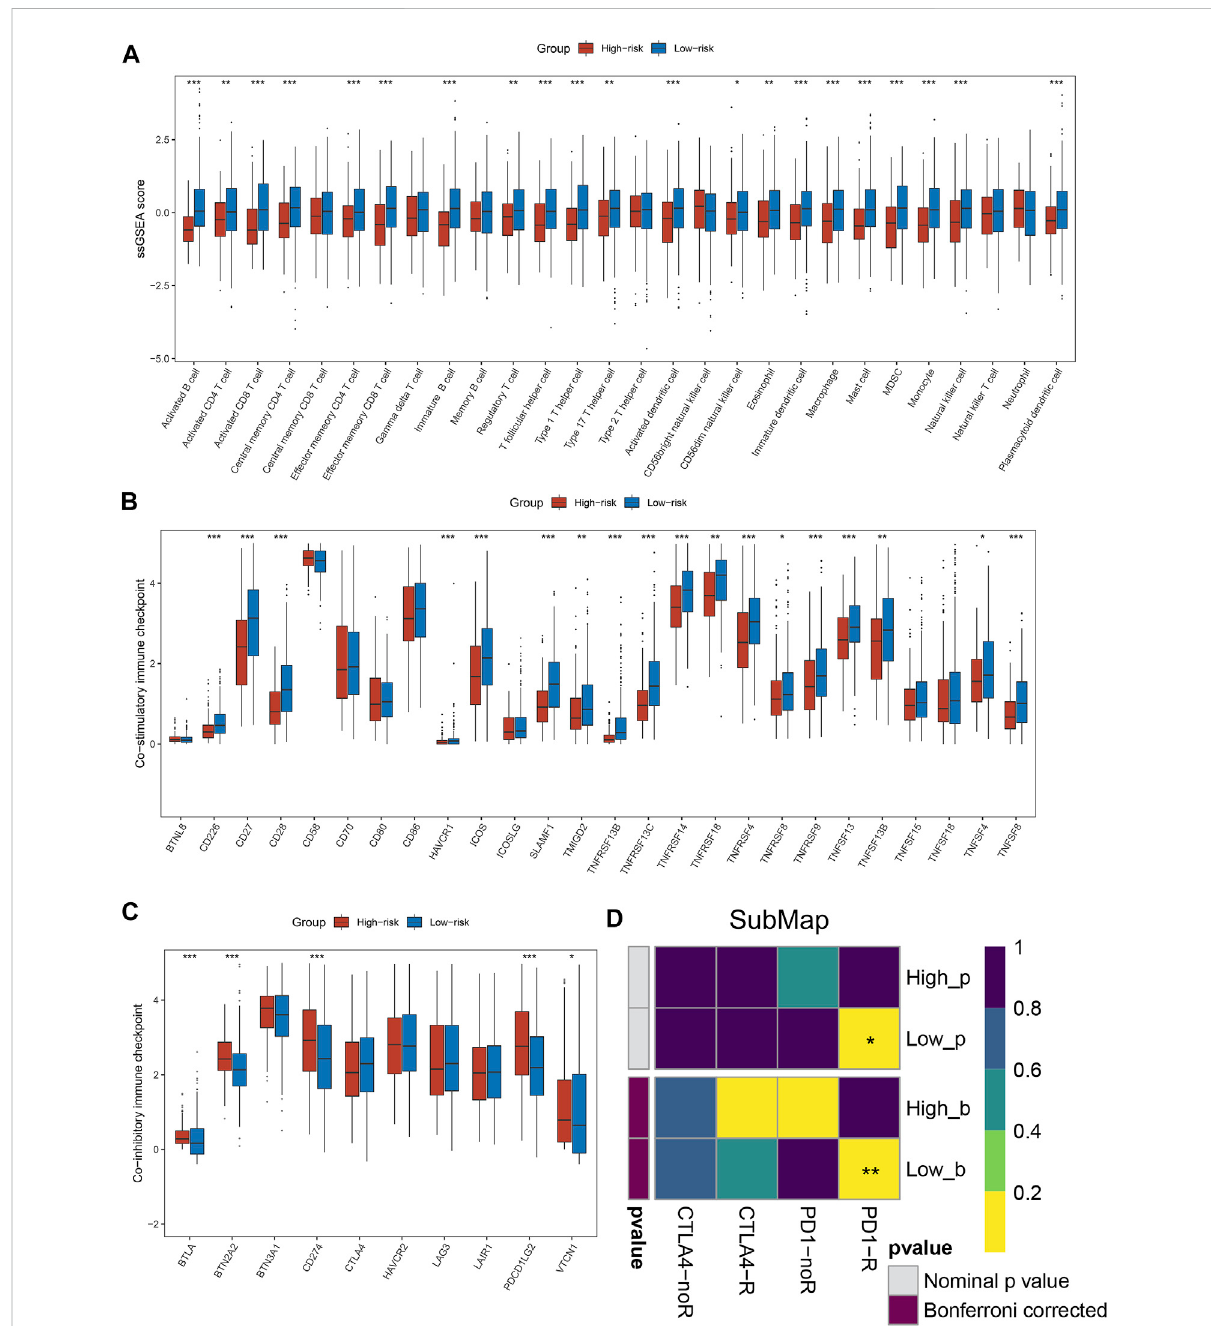
FIGURE 4 Immune in fi ltration analysis and prediction of immunotherapy response in thetwo groups. (A) The abundanceof 28 immune cells betweenthe two groups. (B,C) Comparison of immune co-stimulatory (B) factor and immune co-inhibitory (C) between the two groups. (D) SubMap algorithm evaluated the expression similarity between the two phenotypes and the patients with different immunotherapy responses. * p < 0.05, ** p < 0.01, *** p < 0.001, **** p <